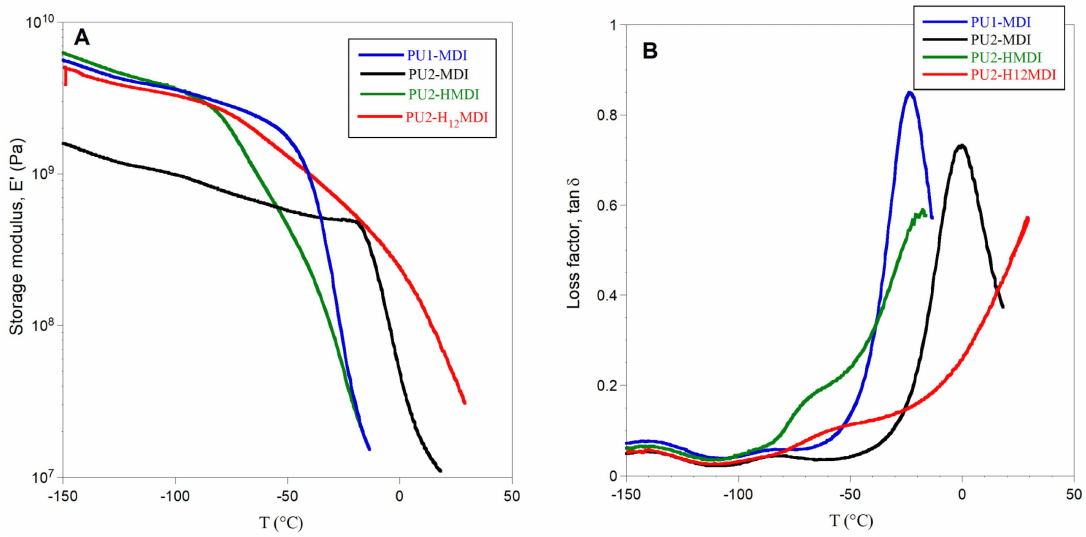
Figure 4. Storage modulus E (cid:48) ( A ) and loss factor tan δ ( B ) of